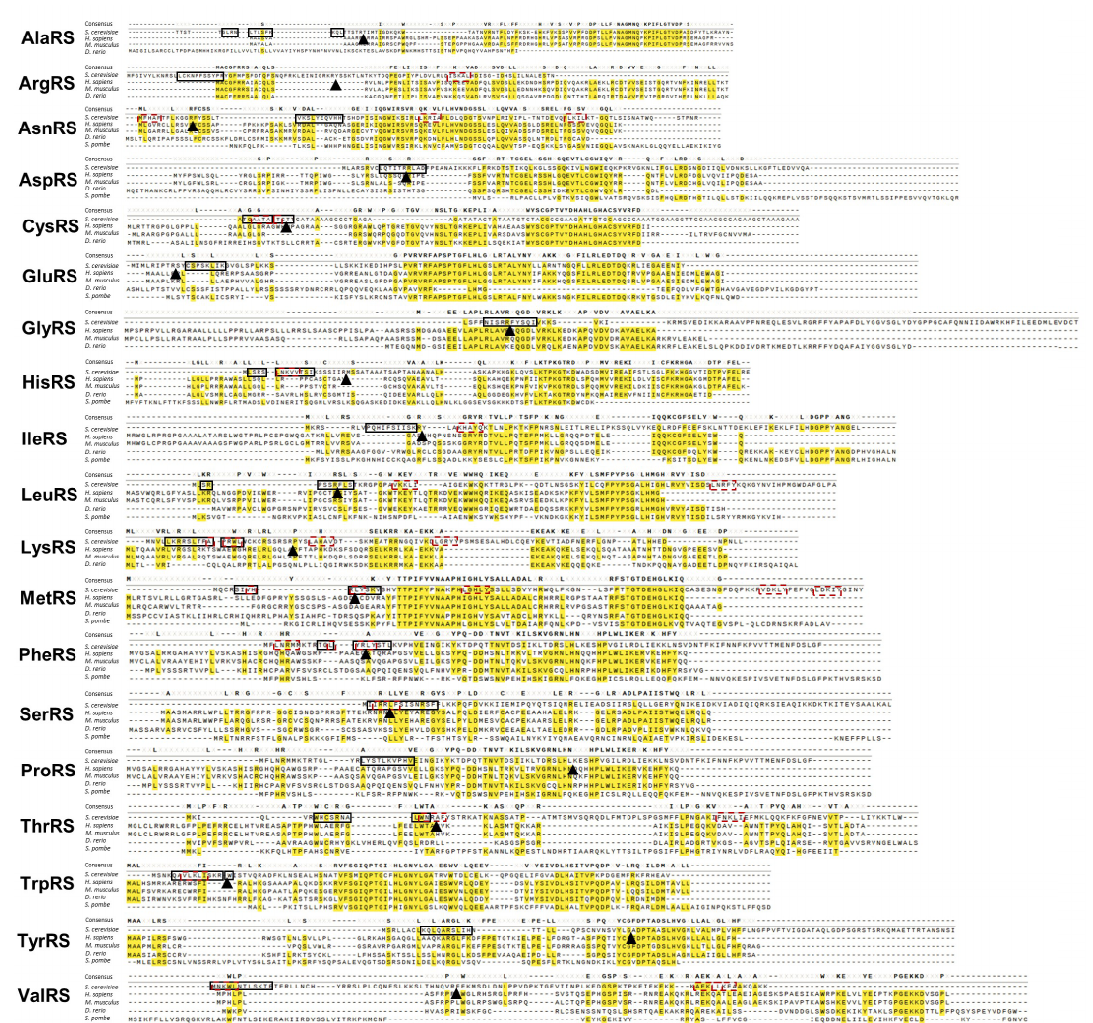
Figure 2. Saccharomyces cerevisiae mt-aaRS predicted-MTS and its conservation. The hundred N terminal amino acids of each S. cerevisiae mitochondrial aaRS were aligned to their human, Mus musculus, Danio rerio, Schizosaccharomyces pombe (when available) orthologs [51]. Consensus sequence is indicated above aligned sequences. Also indicated are the positions of the S. cerevisiae amphipathic helix (continues boxes), Tom20 recognition sequence (dashed red boxes) and Mitochondrial Processing Protease (MPP) cleavage site (arrowheads), predicted by MitoFates [45]. Note that MTS sequence conservation is very low and conserved regions are usually functional domains downstream to the MPP. A higher resolution image is provided as a supplementary material (Supplementary Figure